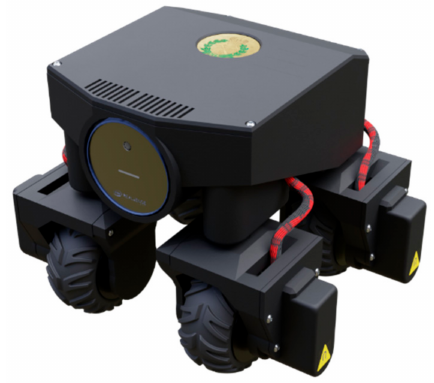
Figure 6. Design of the proposed robot crawler.